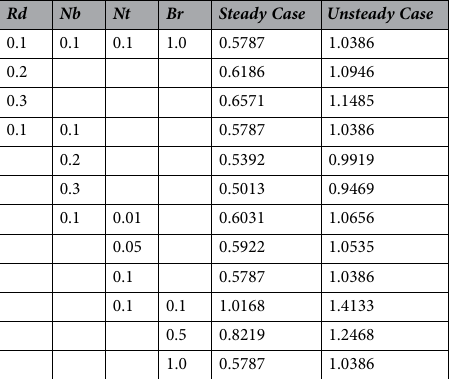
Table 5. Results of Nusselt number – θ ′ ( 0 ) for various parameters.